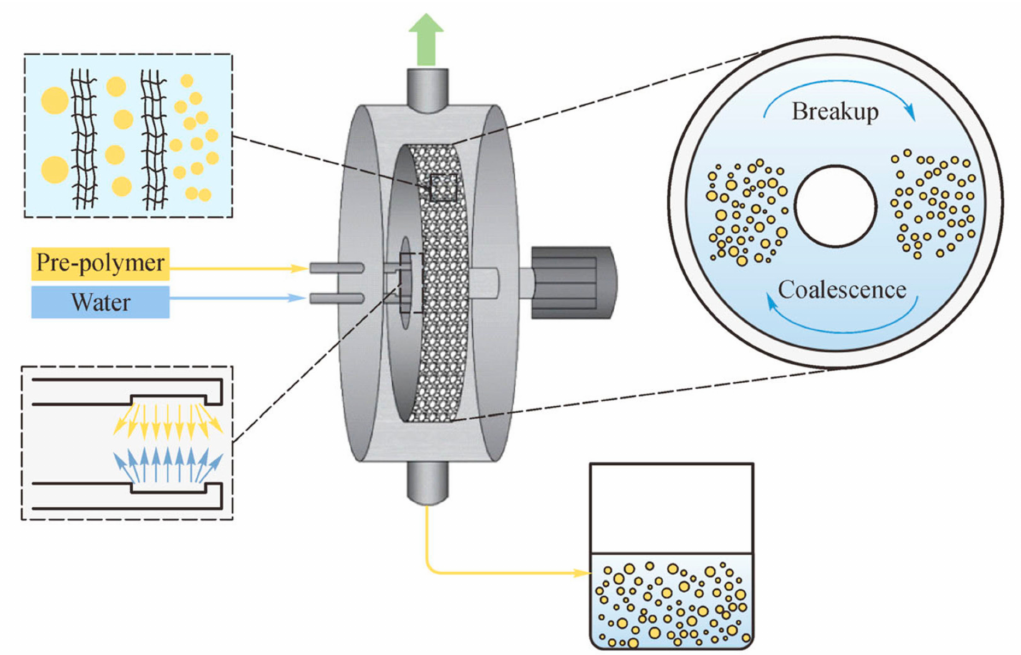
Figure 6. Specific design structure of the RPB reactor [36]. Copyright © (2020) Higher Education